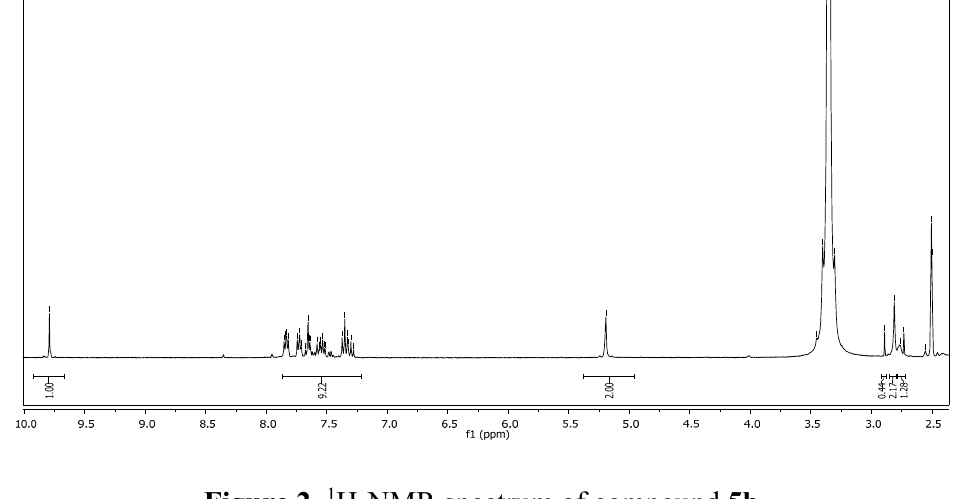
Figure 2. 1 H-NMR spectrum of compound 5b